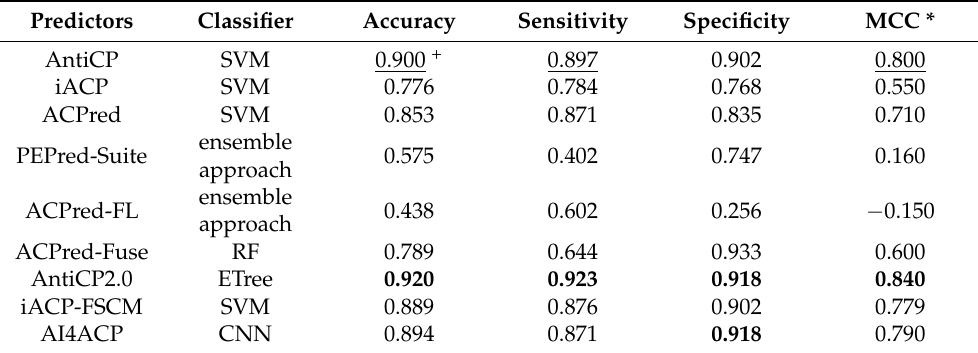
Table 3. Comparison of ACP predictors trained and tested using the alternative data set.